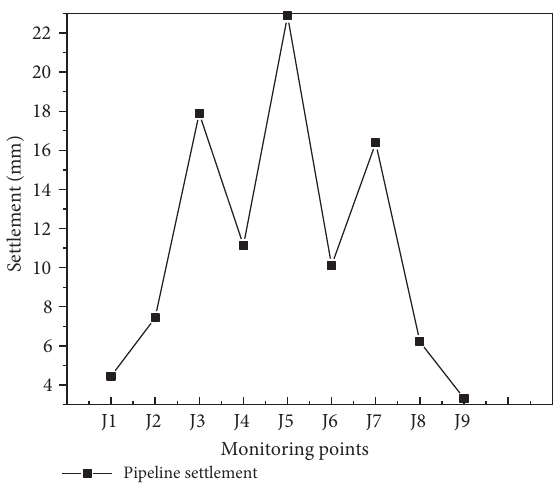
Figure 15: Pipeline settlement curve.